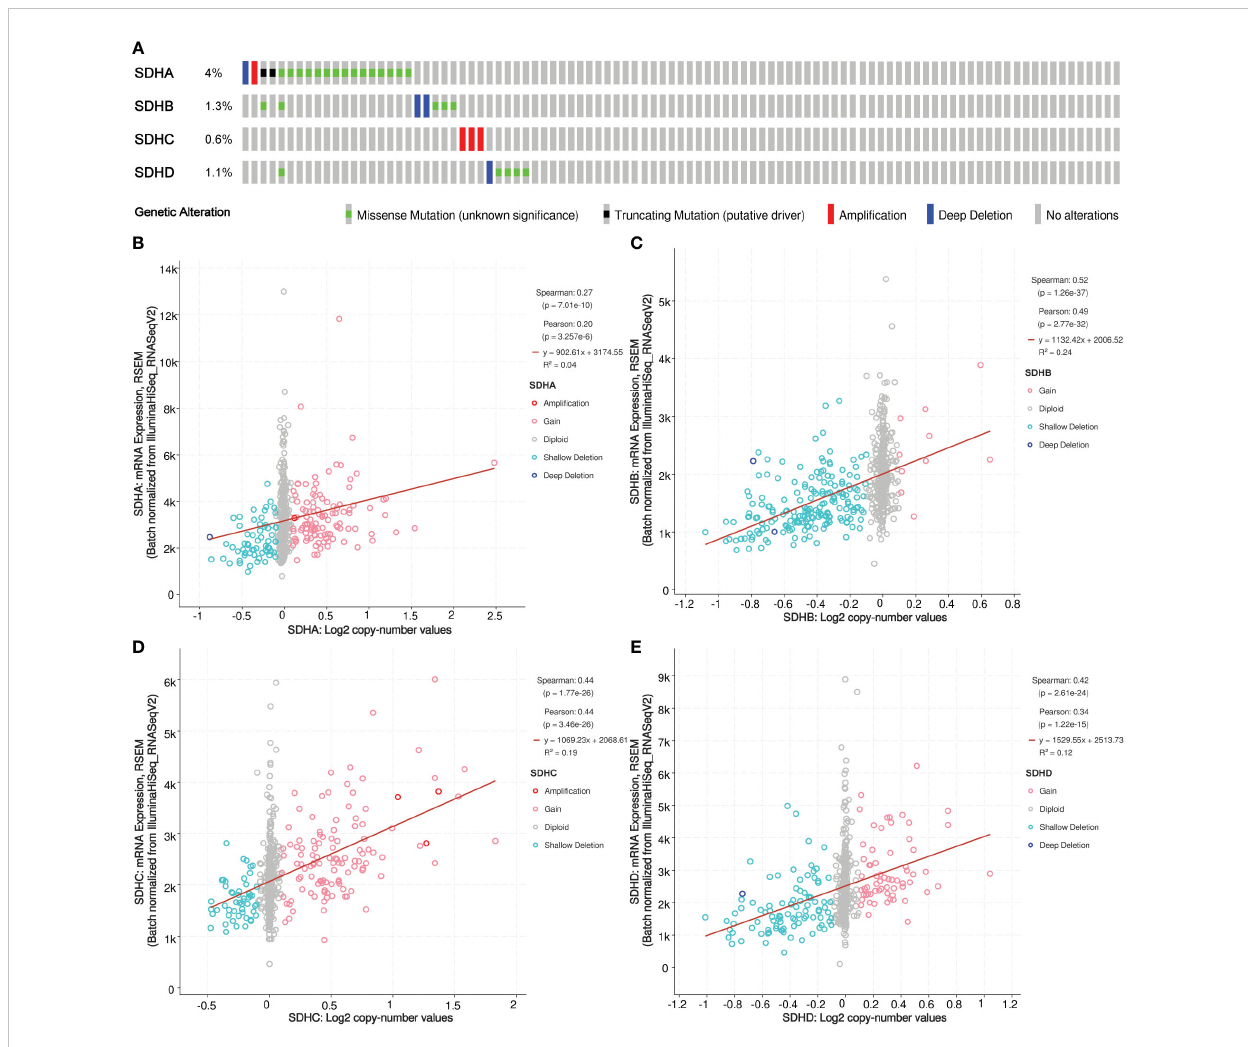
FIGURE 3 Somatic mutation of SDHs. (A) Genetic mutation analysis of SDHs. (B-E) Relationship between CNA in SDHs and expression of